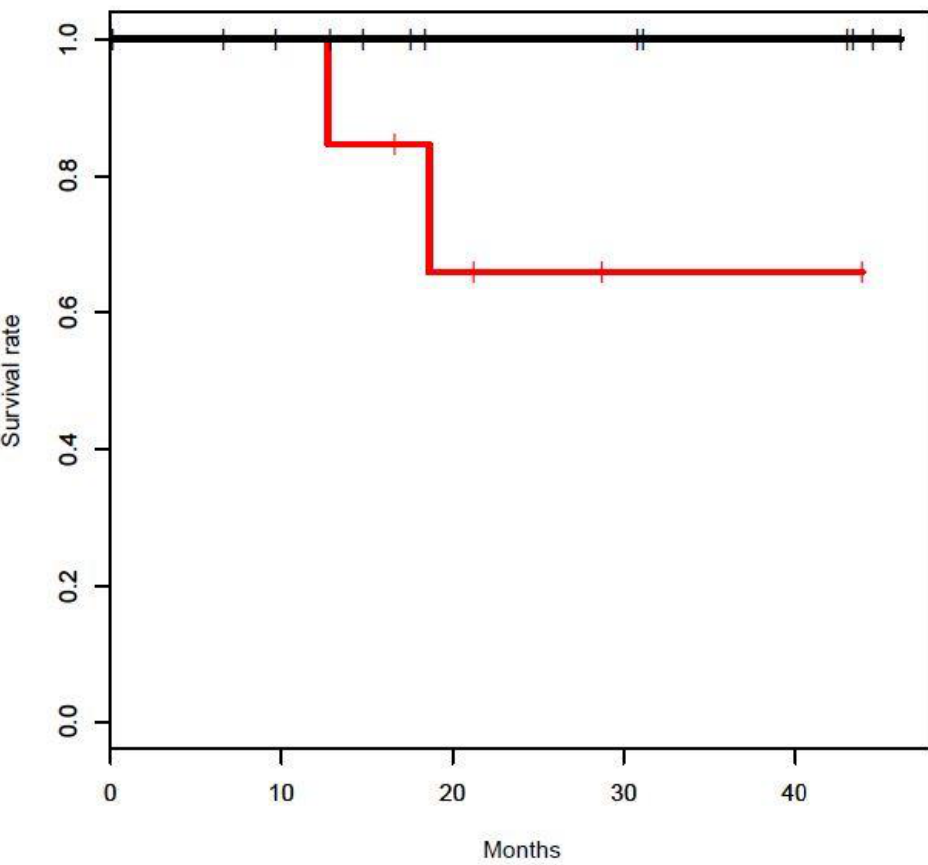
Figure 3. Landmark overall survival at 24 months was poor in CTC detected vs. CTC not-detected early-stage uveal melanoma ( p < 0.05).